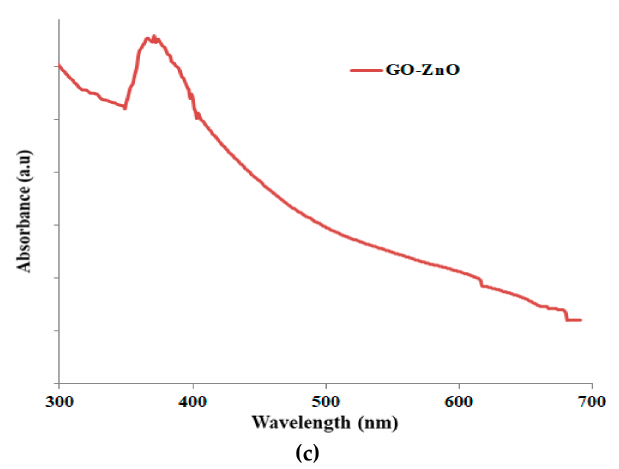
Figure 4. Ultraviolet visible absorption spectra of ( a ) GO; ( b ) ZnO; ( c ) GO-ZnO nanocomposites.